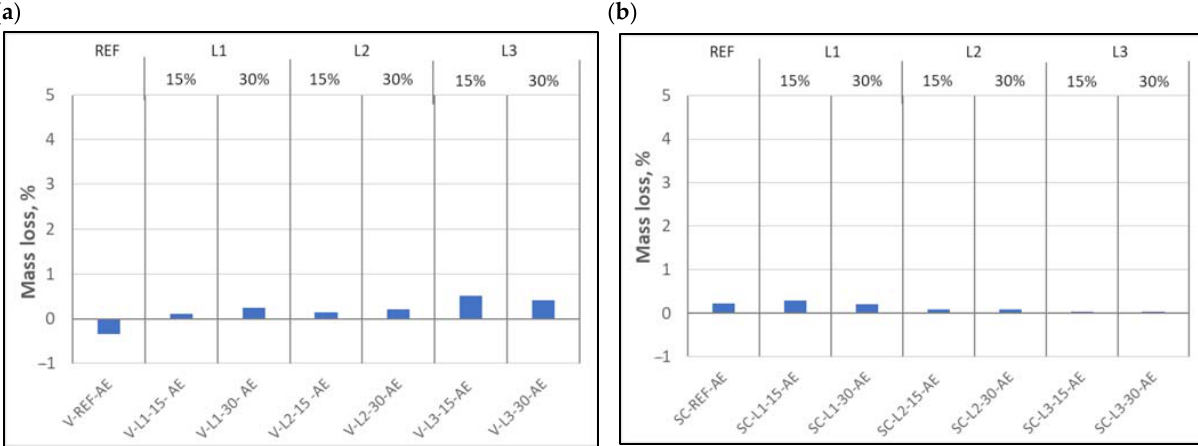
Figure 6. Mass loss of ( a ) vibrated and ( b ) self-compacting concrete with air-entraining admixture after 200 freeze – thaw cycles.